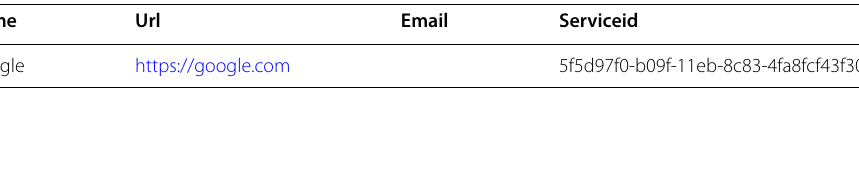
Table 6 Record in servicelicense table Name